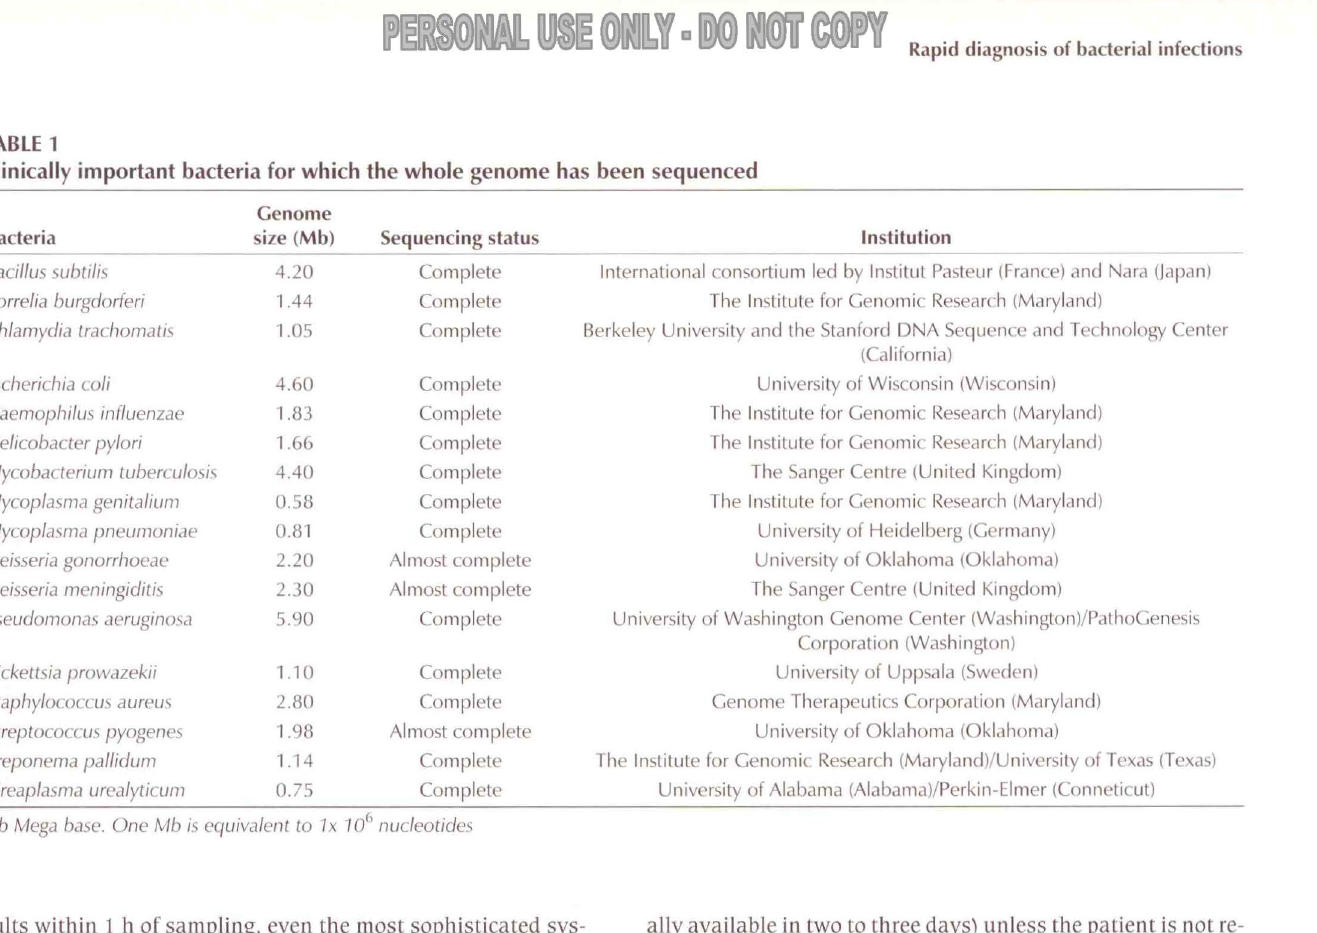
Clinically important bacteria for which the whole genome has been sequenced Genome